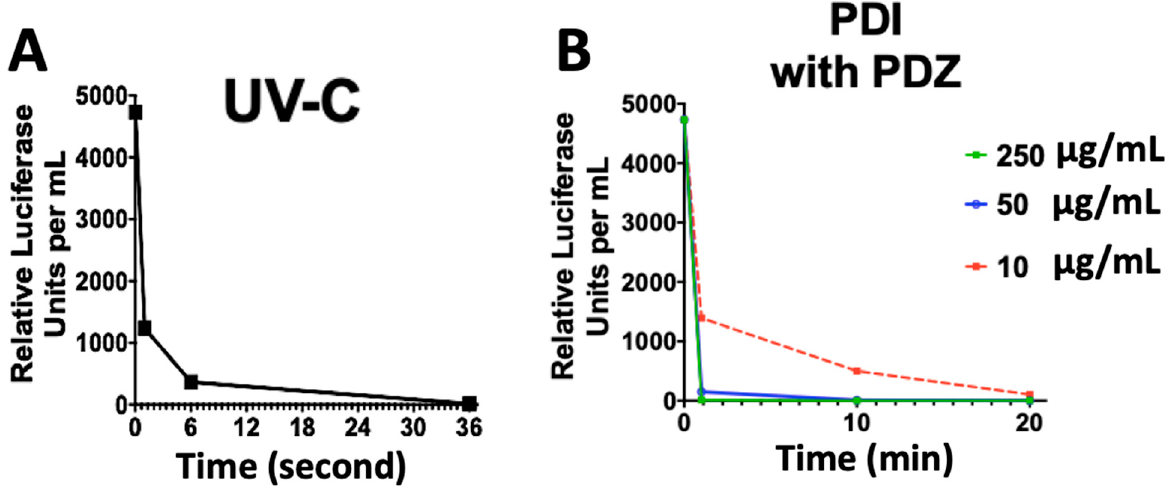
Figure 3. Study of the effect of photo-inactivation of ssRNA pseudovirus considering the relative luciferase units with a time-dependent manner of UV-C irradiation at 1, 6, and 36 s corresponding to doses of 10, 60, and 360 mJ/cm 2 , respectively ( A ); and PDZ-based PDI in a serial dilution of 10, 50 and 250 μ g/mL in a time-dependent manner of 1, 10 and 20 min which equal the light doses of 1.8, 18 and 36 J/cm 2 , respectively ( B ). Data are ± means S.E.M. ( n = 3).